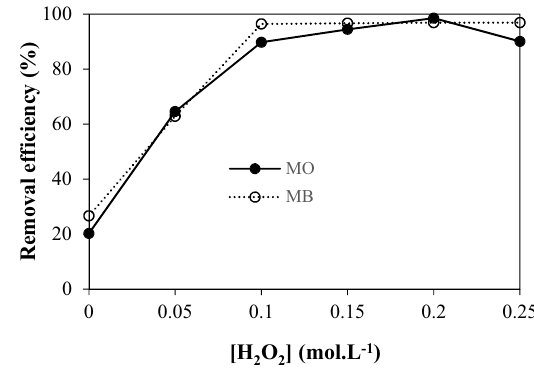
Figure 4: E ff ect of H 2 O 2 concentration on the removal e ffi ciency.